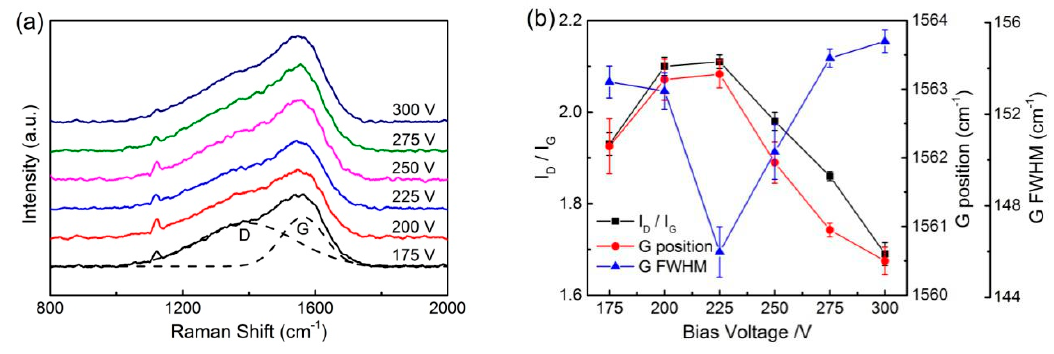
Figure 2. ( a ) Raman spectra of DLC films with various ratios of sp 3 / sp 2 . ( b ) Gaussian fitting results for Raman spectra.